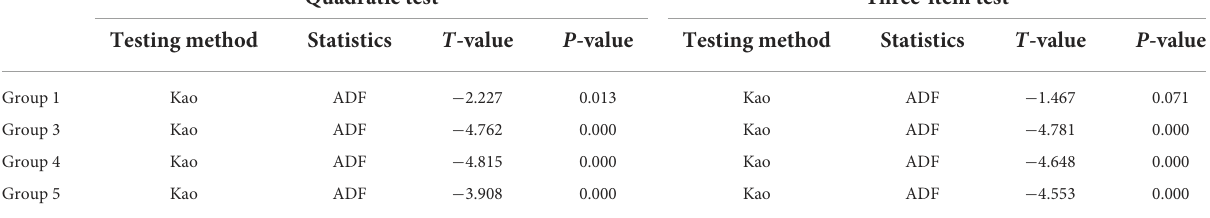
TABLE 6 Panel cointegration test